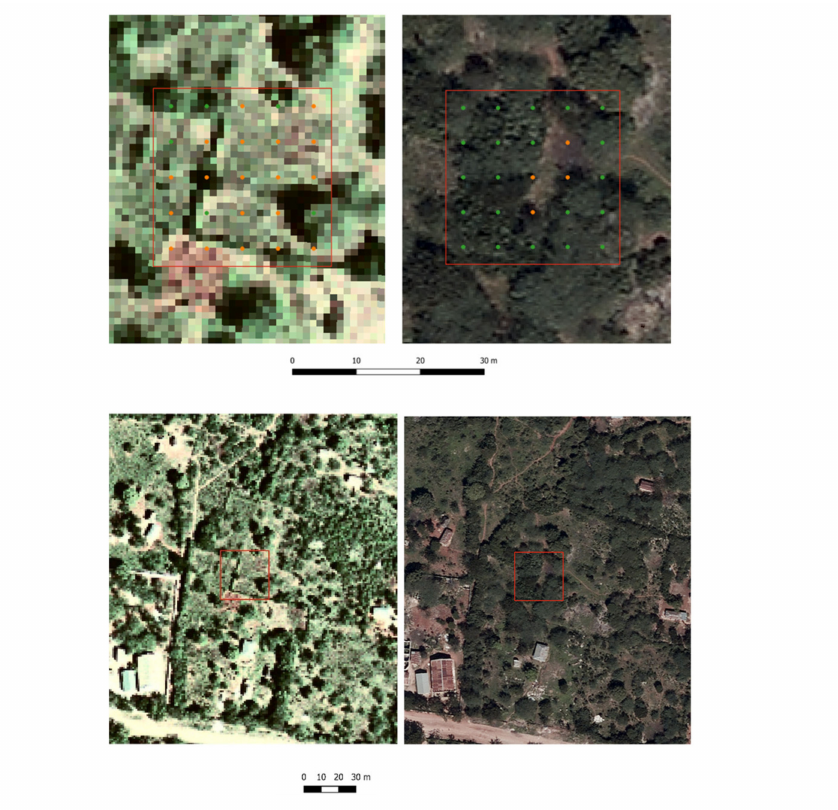
Figure 7. Examples of sample unit visualization and of land cover classification using 25-point grid and orthophotos from 2002 (pictures on the right) and 2010 (pictures on the left). Pixel size: 0.073 ha. Pixel boundaries are traced in red. For each sample unit (No. 96 and No. 272), the two pictures at the bottom show the pixel visualized within its context, and the two pictures at the top show the land cover